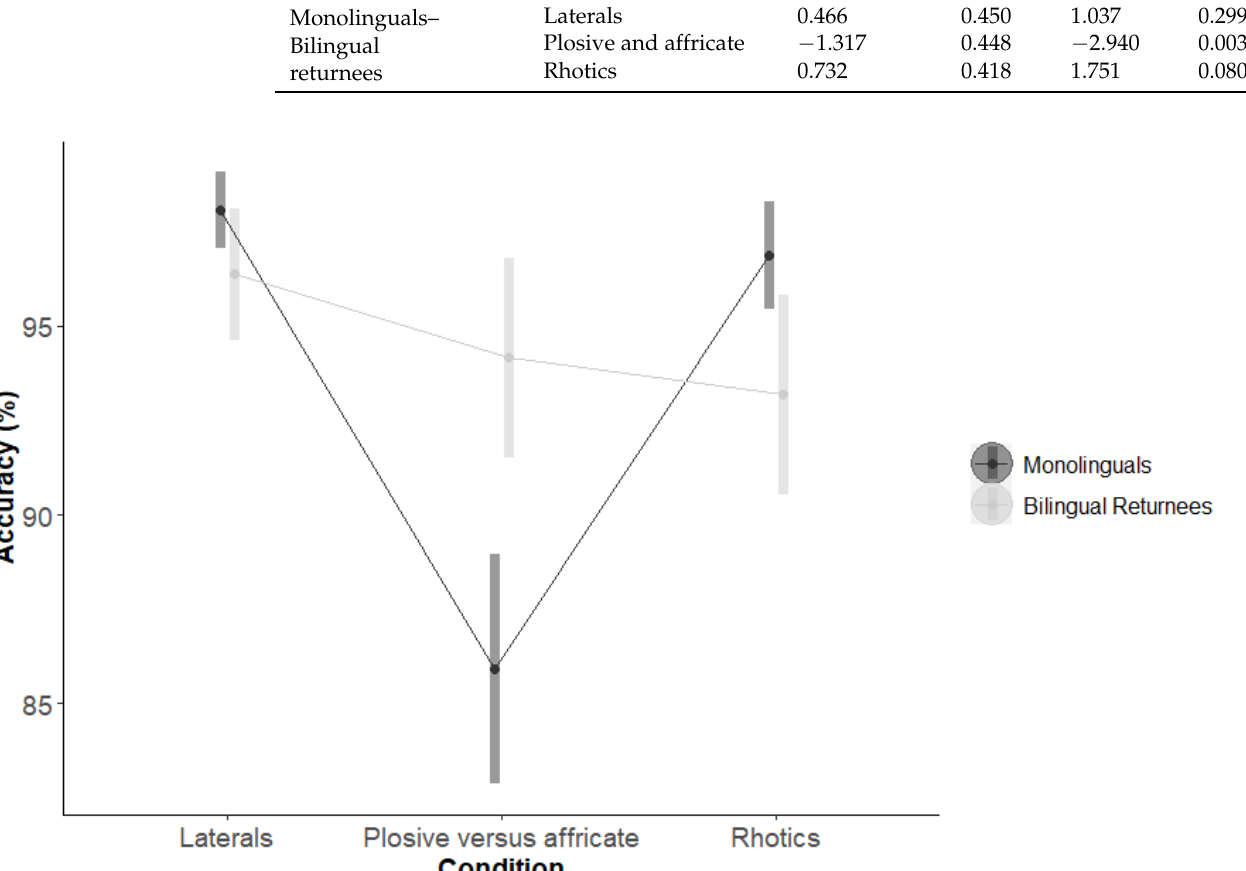
Figure 2. Perception accuracy in Albanian–English bilingual returnees versus Albanian monolingual speakers across each condition. The vertical bars represent 95% confidence intervals.